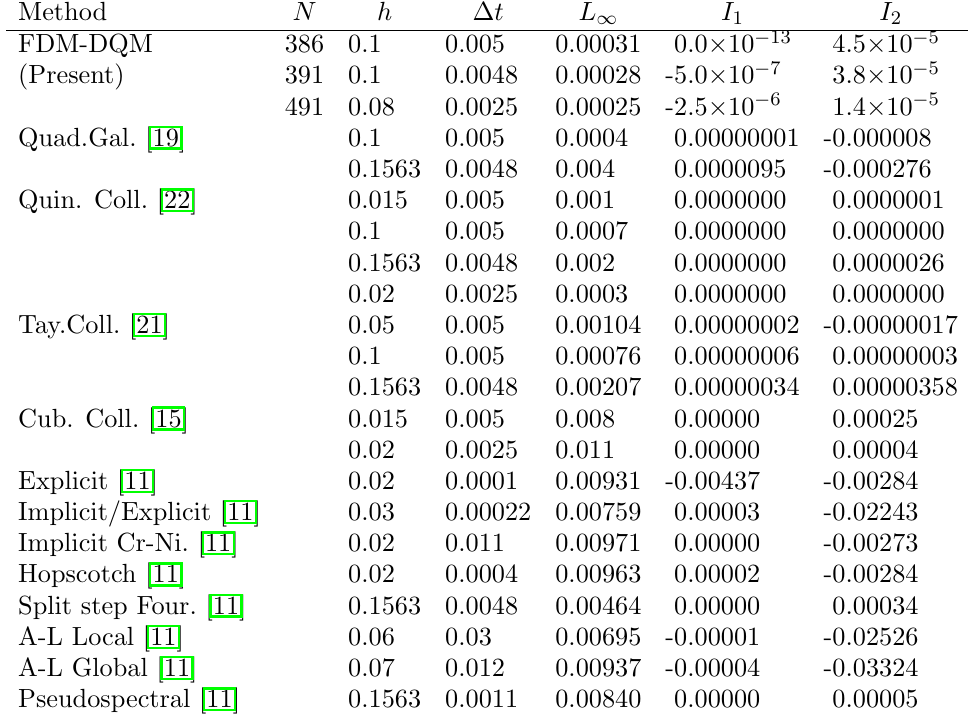
Table 5. L ∞ error norm and relative changes of invariants of single soliton, amp. = 2 , t =